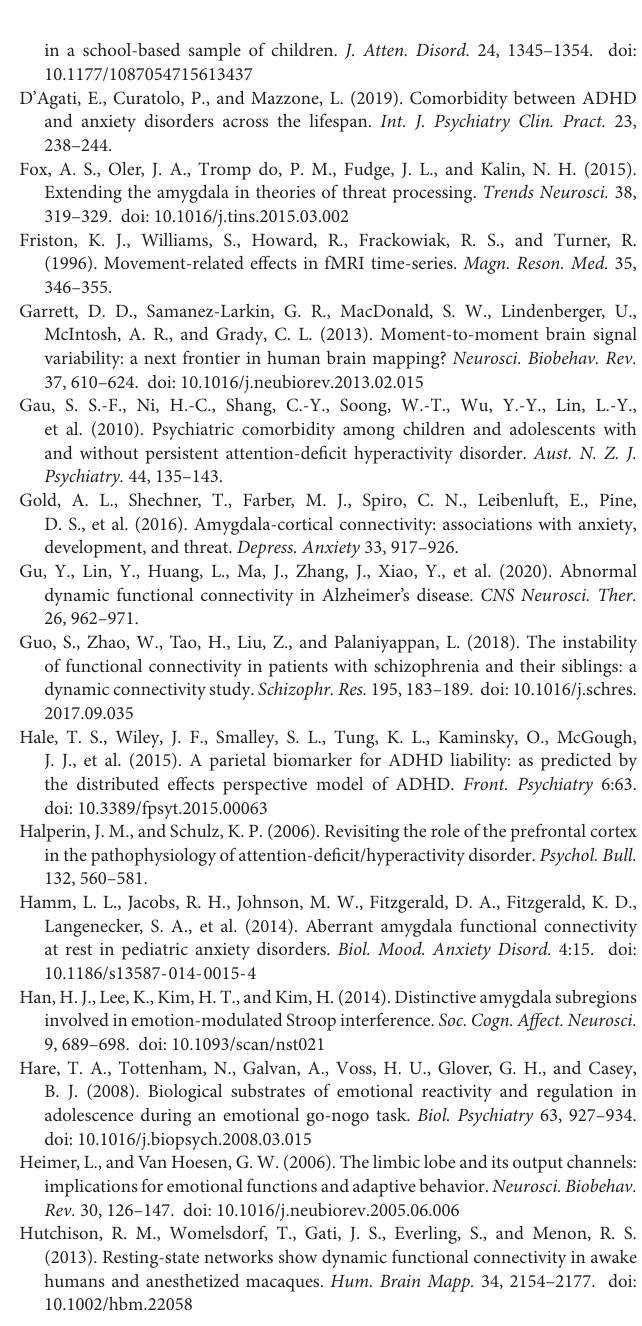
Supplementary Figure S1 | Brain areas with significant dFC differences between children in the ADHD and HC groups (the window width was set as 32/64 TR). ADHD, attention-deficit/hyperactivity disorder; HC, health control; TR, repetition